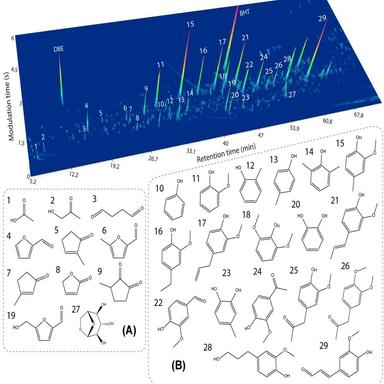
GCxGC/TOF-MS chromatogram with the main PL peaks assigned. (A) Aliphatics and furan monomers and (B) Phenolic monomers. DBE is the IS and BHT is the THF stabilizer.